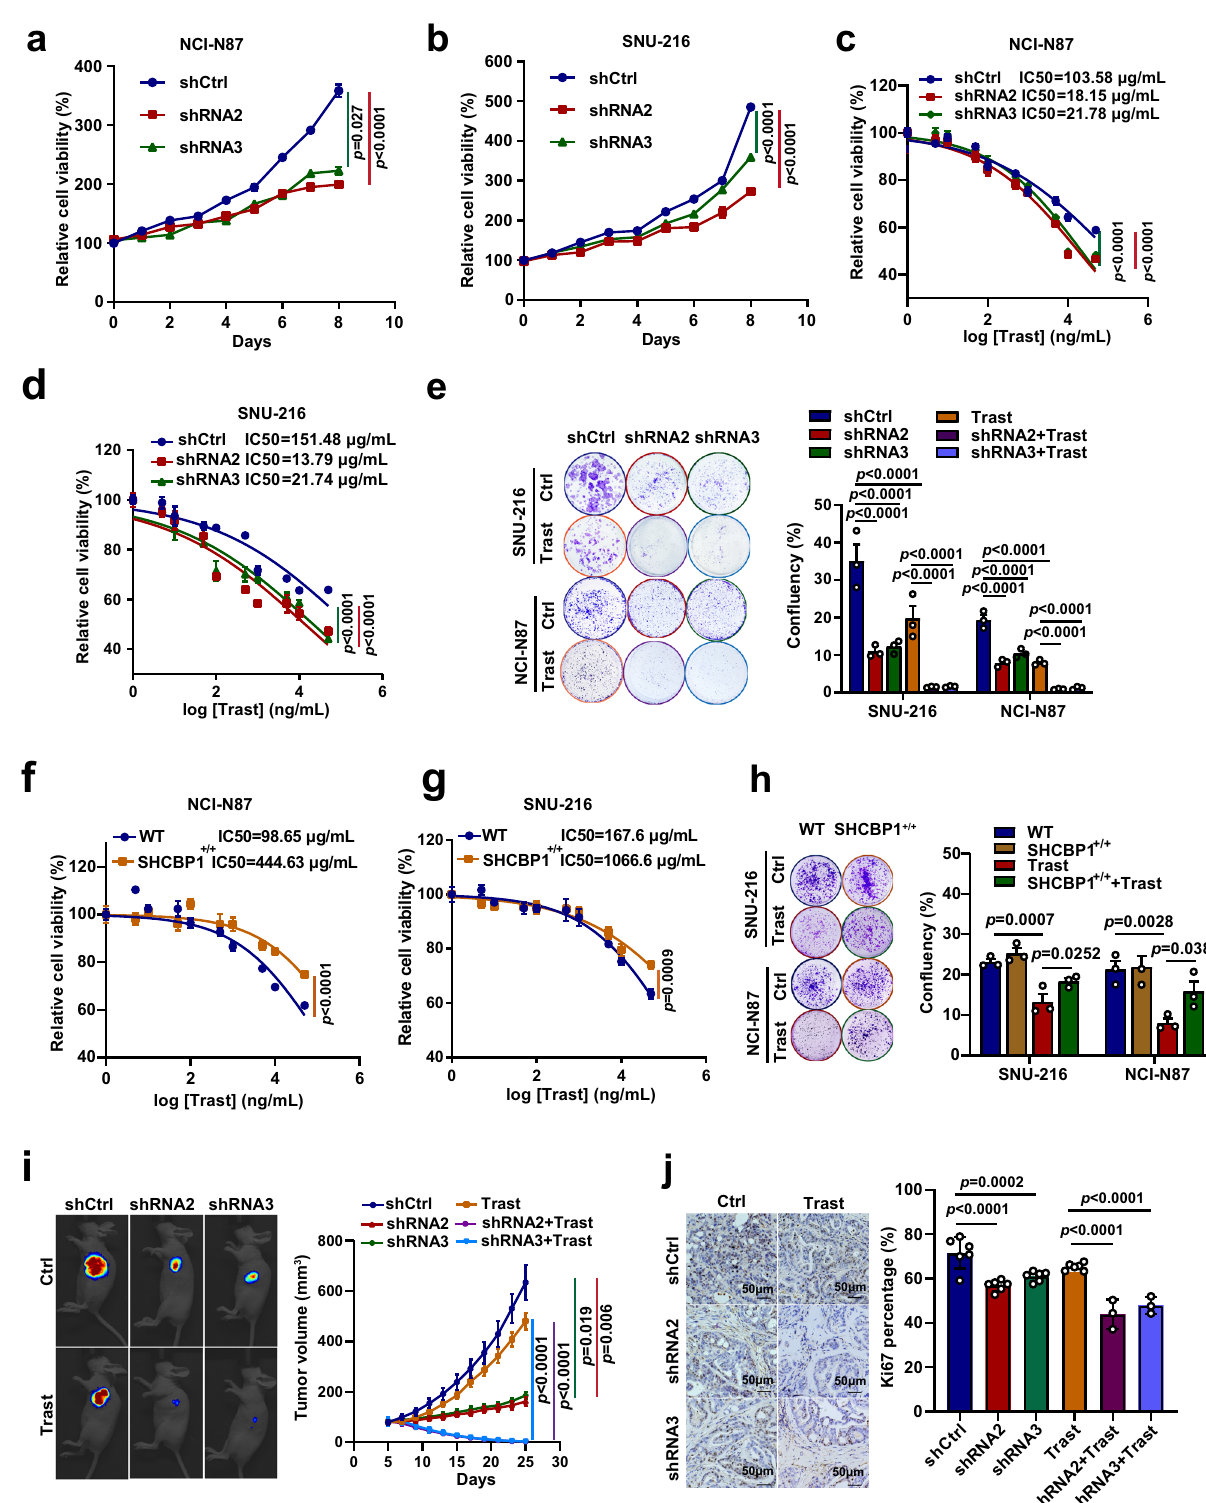
disappeared in response to calf intestinal phosphatase treatment. Overexpressed PLK1 led to a pronounced increase in the slower migrating MISP band, suggesting that PLK1 catalyzed MISP phosphorylation (Fig. 5e). Moreover, in vitro kinase assays with recombinant MISP and PLK1 were performed, and strong phosphorylation of MISP by PLK1 was detected (Fig. 5f). In order to better understand the role of SHCBP1 in the process of